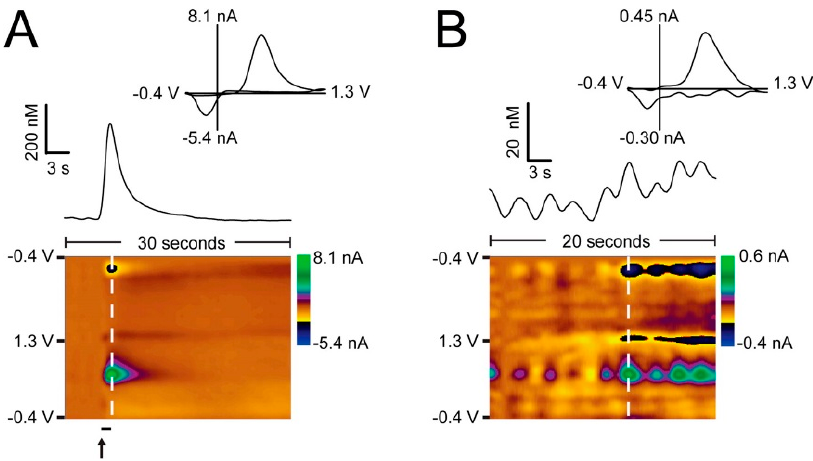
Figure 9 . In vivo measurements of dopamine release using a PEDOT/Nafion-coated carbon-fiber microelectrode. Current versus time traces were extracted from the color plot at the peak oxidation potential for dopamine (~ 600 mV). The representative cyclic voltammograms were taken from the vertical white dashed line on the color plots. ( A ) Dopamine release was electrically evoked by stimulation (black bar, 40 pulses at 60 Hz, ±150 µA, 2 ms per phase) of the medial forebrain bundle and monitored in the nucleus accumbens of a Sprague-Dawley rat. ( B ) Spontaneous transients recorded in the nucleus accumbens of an isoflurane-anesthetized Sprague-Dawley rat [131]. Copyright 2015, American Chemical Society.